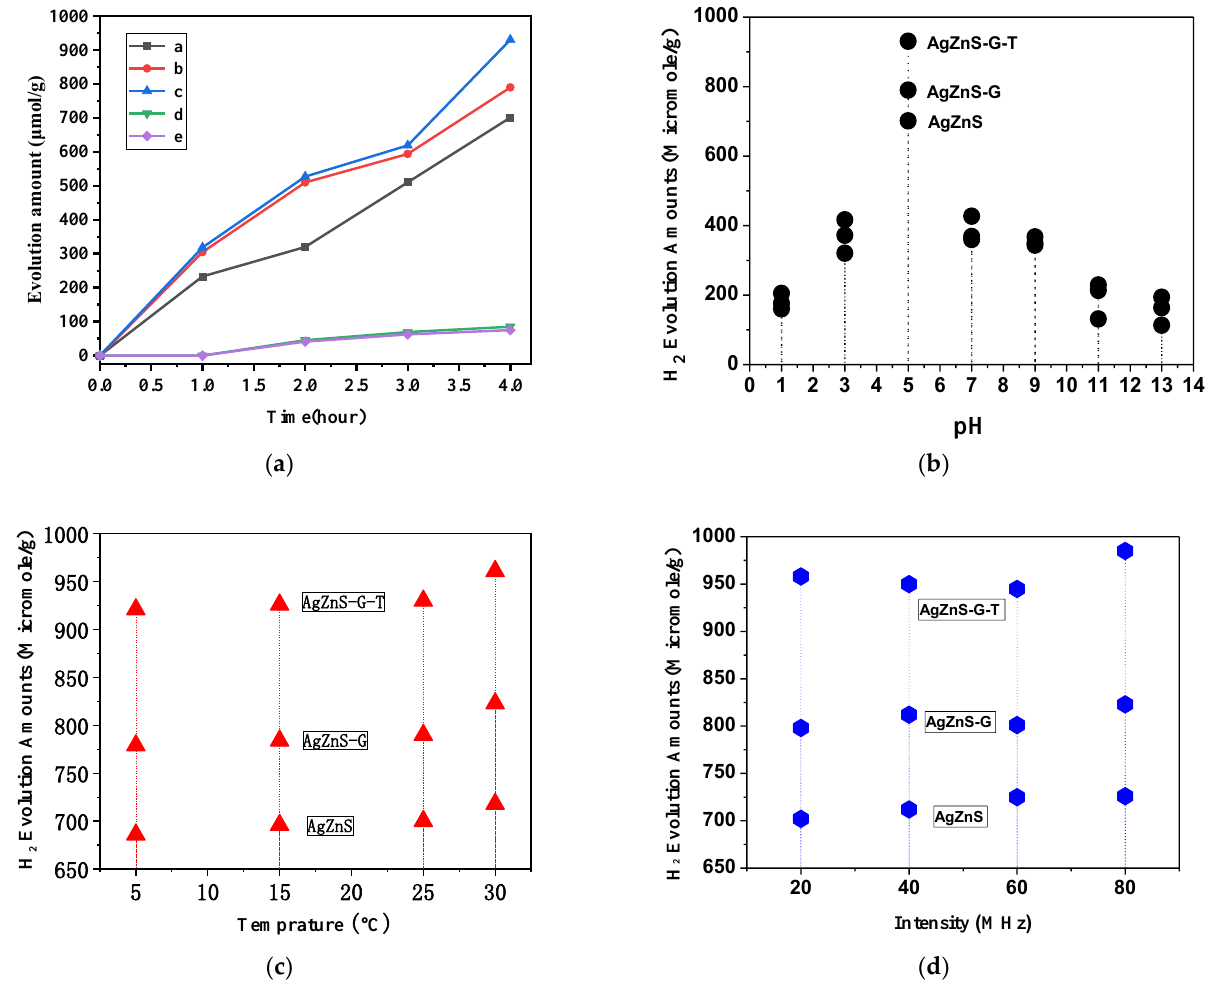
Figure 7. ( a ) Hydrogen evolution efficiency of a. AgZnS, b. AgZnS-G, c. AgZnS-G-T, d. GO, and e. TiO 2 photocatalysts over time; ( b ) hydrogen evolution amount of AgZnS, AgZnS-G, and AgZnS-G-T photocatalysts with different pH condition; ( c ) with different temperature conditions; ( d ) with different ultrasonic intensity. Table 1. H 2 evolution amounts of other catalysts have been reported.